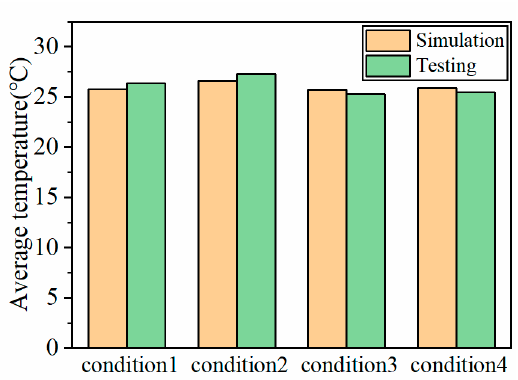
Figure 11. Comparison of simulation results and experimental results of average temperature in the